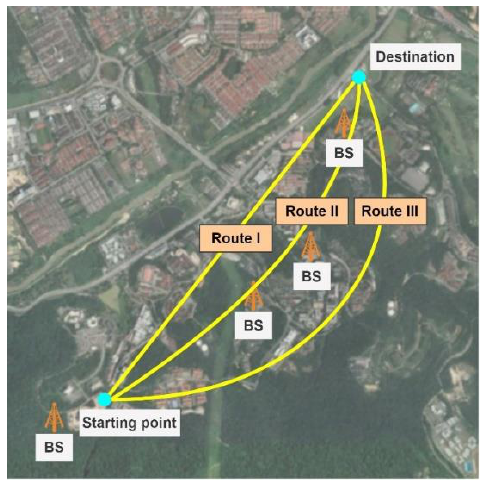
Figure 3. Illustration of the conducted aerial drive test on the UKM campus in three different routes.